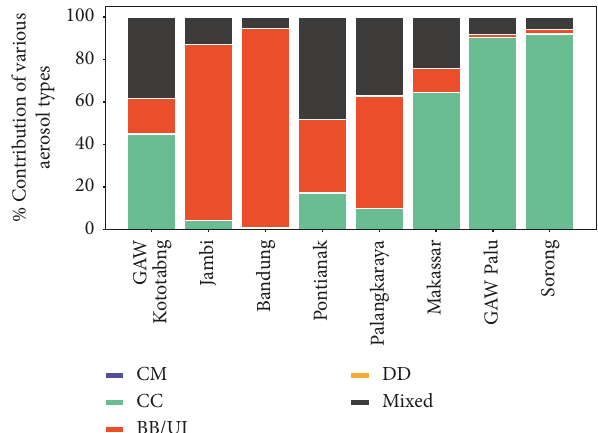
Figure 5: Aerosol types’ contribution to atmospheric composition at AERONETsites over Indonesia from 2009 to 2019 obtained from the relationship between MODIS AOD 550nm and AE (Figure 4) according to aerosol classification in Table 1.